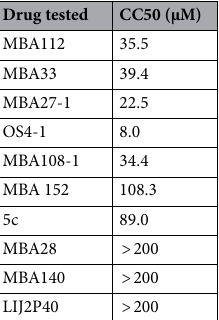
Table 2. CC50 on MRC5 cells of the ten drugs studied for their